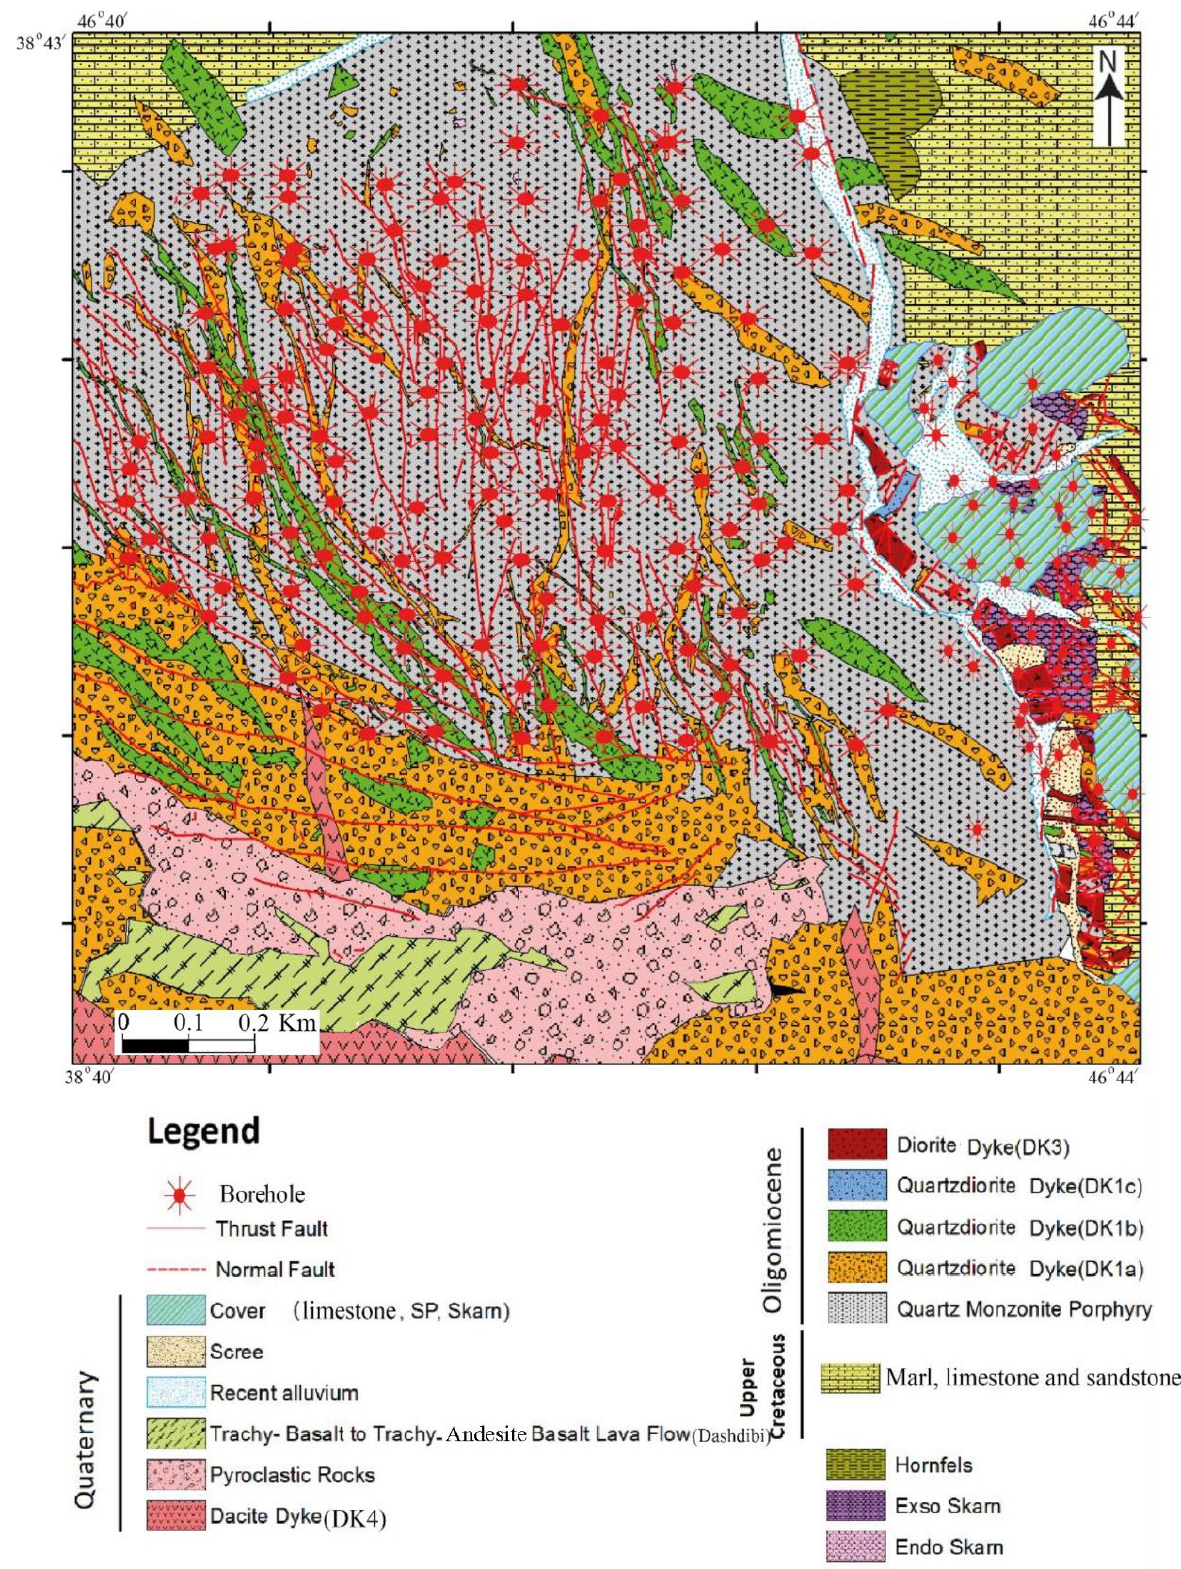
Figure 2. Geological map of the Sungun Copper Mine [11] .